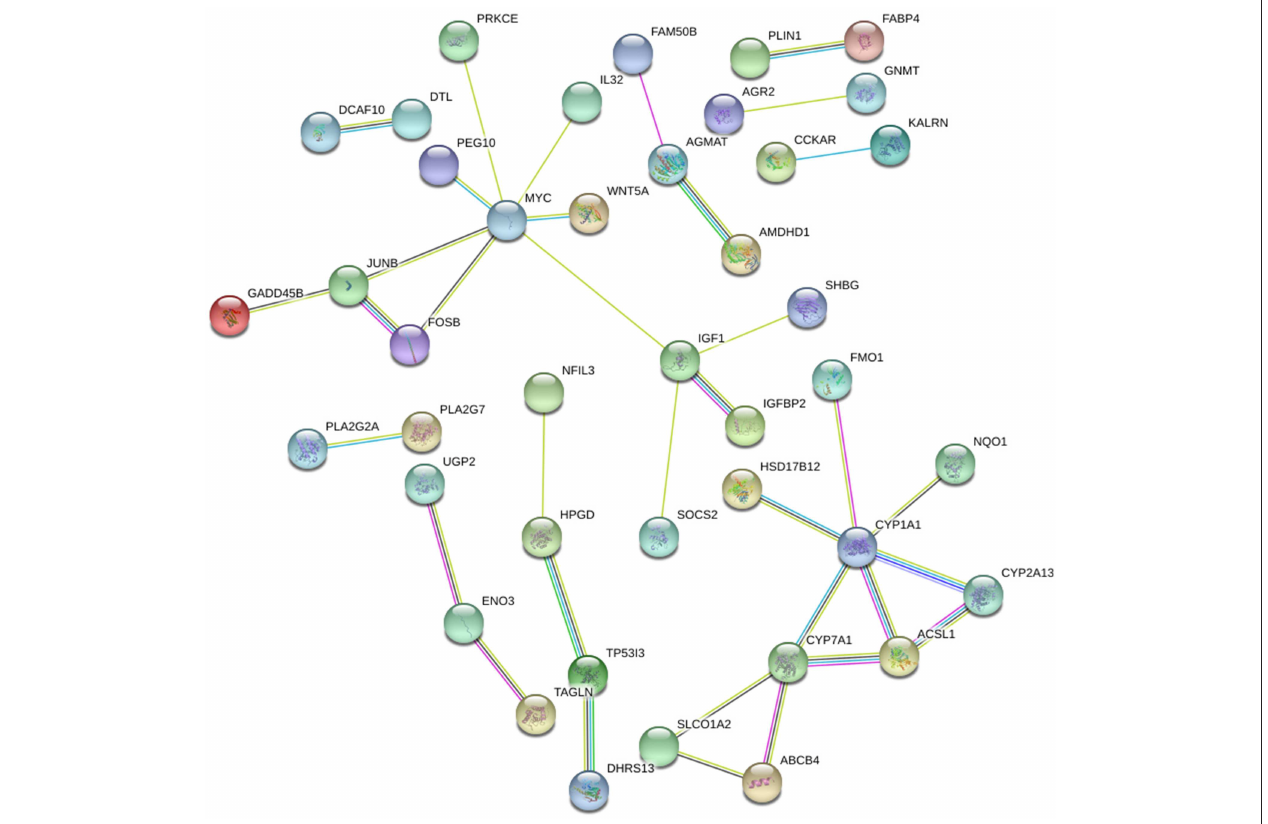
FIGURE 4 | The PPI network of DEGs in NAFLD (STRING). The top 10 genes with most connections included CYP1A1, MYC, CYP7A1, IGF1, JUNB, HPGD, FOSB, ACSL1, ENO3, and